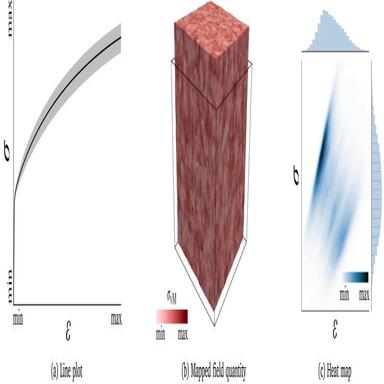
Approaches for data evaluation, exemplary shown for the visualization of stress and strain. Figure adopted from with permission from Cambridge publications.